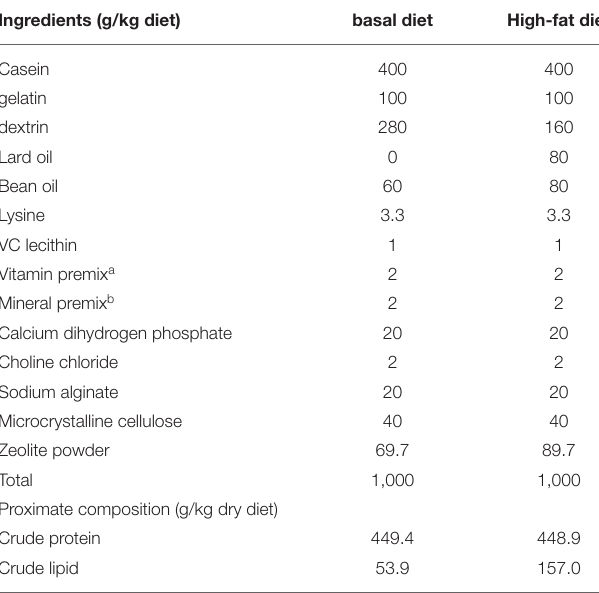
TABLE 2 | The primer sequences for quantitative ( q PCR) analysis of lipid metabolism and inflammation-related